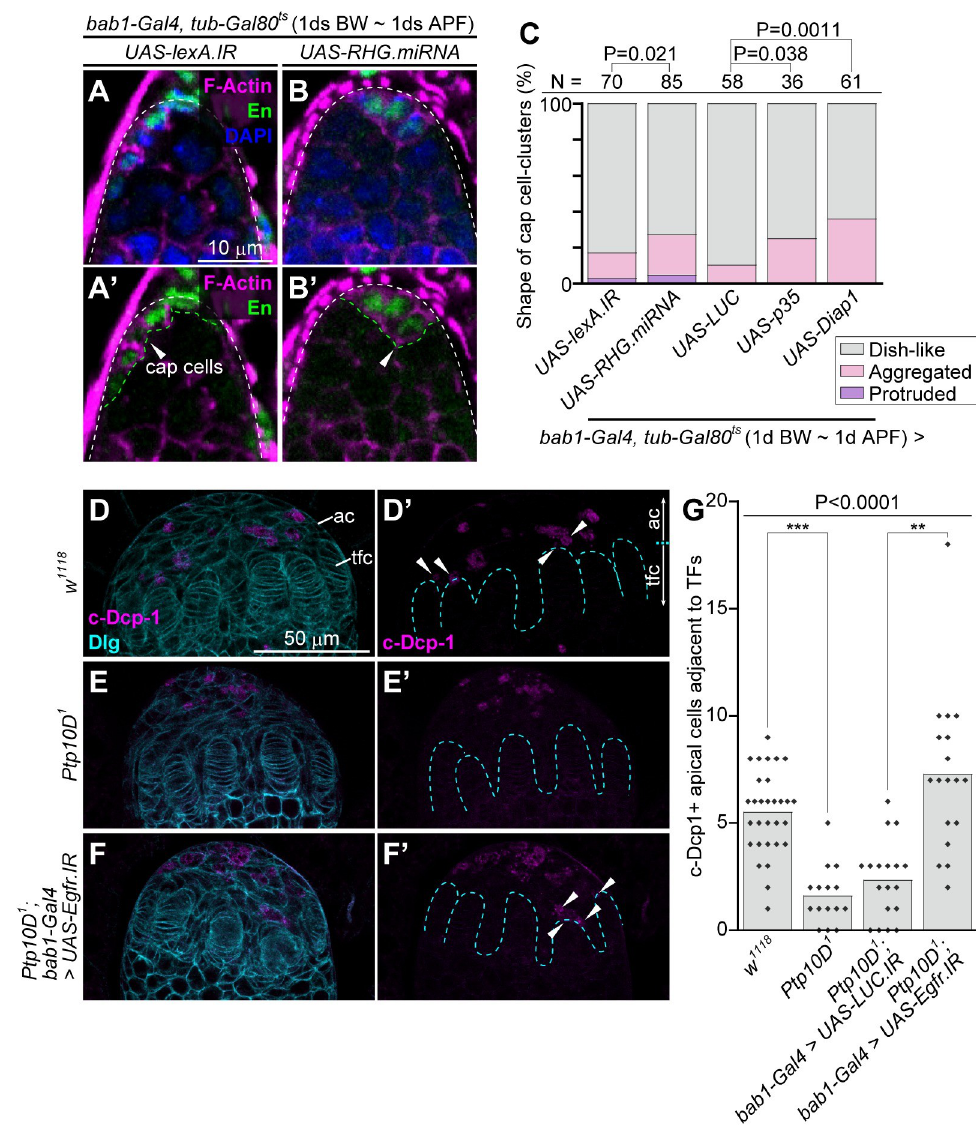
Fig 4. Ptp10D 1 causes the suppression of apoptosis in the apical cells. (A and B) Germaria of indicated genotypes (upper) 2 days after eclosion that are treated with the temperature-sift (29˚C, 1d BW ~ 1d APF) are shown. Germaria with dish-like (A) and abnormal (B) cap cell-clusters are shown as examples. (A’ and B’) Magenta/green channels of (A and B). White dashed lines in (A, A’, B, and B’) and green dashed line with arrowheads in (A’ and B’) indicate outlines of germaria and cap cell-clusters, respectively. Scale bar in (A) is 10 μ m, and applicable for (A’, B and B’). (C) 100%-stacked bar graph represents % of germaria with normal (gray), aggregated (pink), and protruded (purple) cap cell-clusters in indicated genotypes. lexA . IR (use same data value in Fig 3A, lane 1) and LUC are used as controls. Numbers (N) of samples observed and P-value for Fisher’s exact test are shown at the upper. (D-F) Female gonads at wandering L3 stage (corresponding to the stage of S7D Fig) are labeled with anti-c-Dcp-1 antibody (magenta) and anti-Dlg antibody (cyan). The cell layers located at a opposite side of fat body-adherent surface are shown. Genotypes of samples are indicated at the left. Images are processed by the Z-stack projection of two sections (corresponding to 3 μ m thickness) to visualize the boundary between terminal filament cells. (D’-F’) Magenta channels of (D-F). Scale bar in (D) is 50 μ m, and applicable for (E, F, and D’-F’). Cyan dashed lines in (D’-F’) indicate boundary between apical cells (ac) and terminal filament cells (tfc). Arrowheads in (D’ and F’) indicate the c-Dcp-1-positive apical cells which adjacent to terminal filaments. (G) Bar graph overlaid with beeswarm plots represent numbers (No.) of c-Dcp-1-positive apical cells adjacent to terminal filaments (TFs) per larval gonads in indicated genotypes. LUC . IR was used as control. P-value for Kruskal-Wallis rank sum test are shown. P-values ( *** P < 0.0001, ** P < 0.001) for Mann-Whitney U test with Bonferroni correction (post-hoc test) are